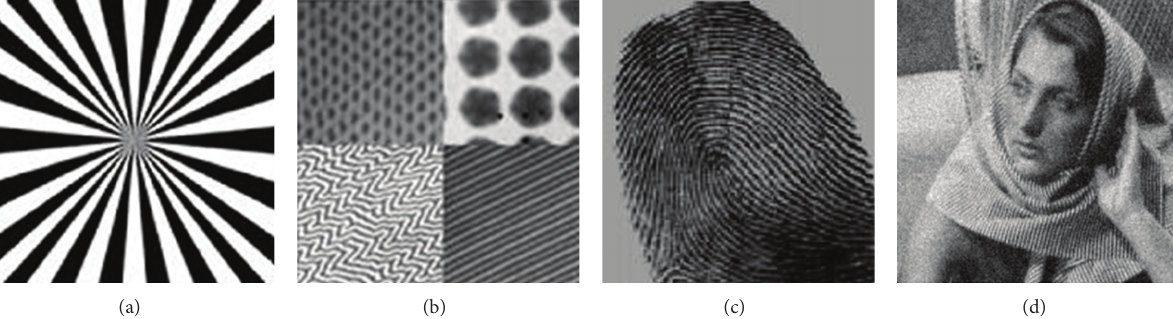
Figure 1: Test images. Left to right: (a) and (b) two synthetic textured images; (c) fingerprint image; (d) a portion of noisy Barbana image which generated by adding Gaussian noise with standard deviation 20 to the clean